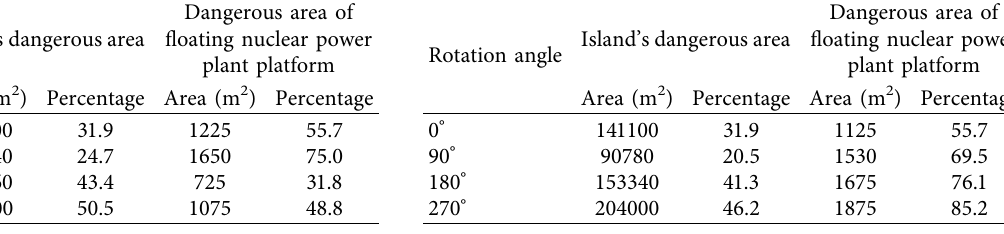
Table 2: The area and proportion of the danger area of the four breaks.